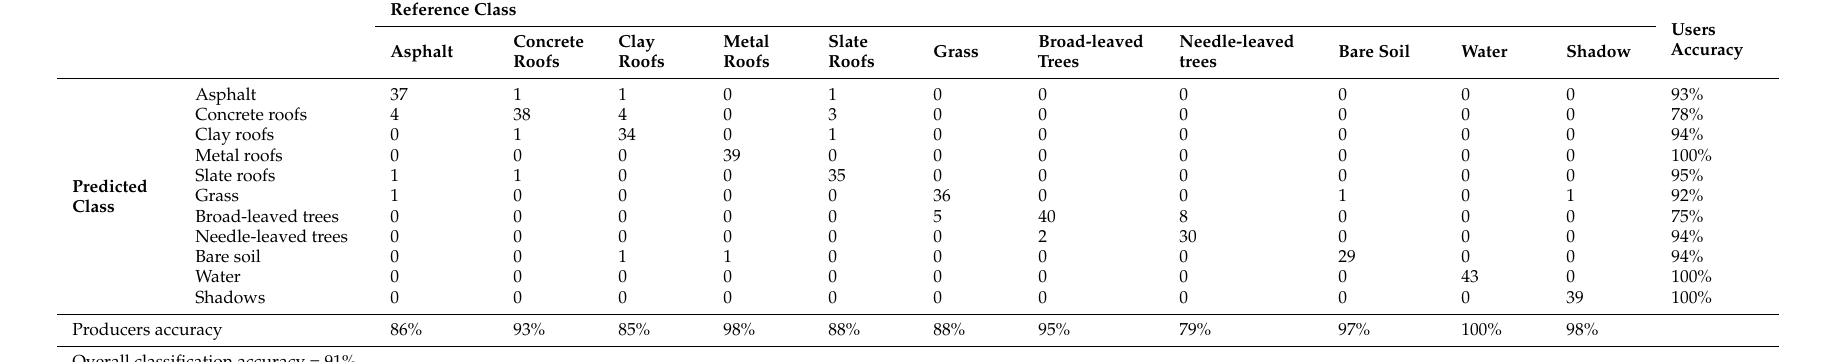
Table 3. Error matrix for the OBIA classification using 2 m spatial resolution, 8 spectral band imagery.